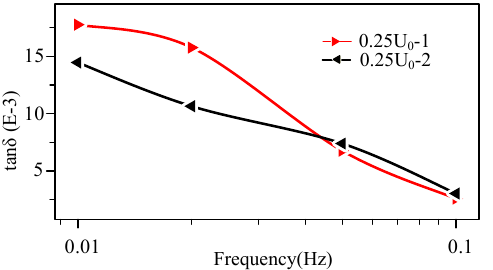
Figure 12. The previous and second lower voltage measurement before and after a higher voltage (at the late aging stage, aging time 1536 h).